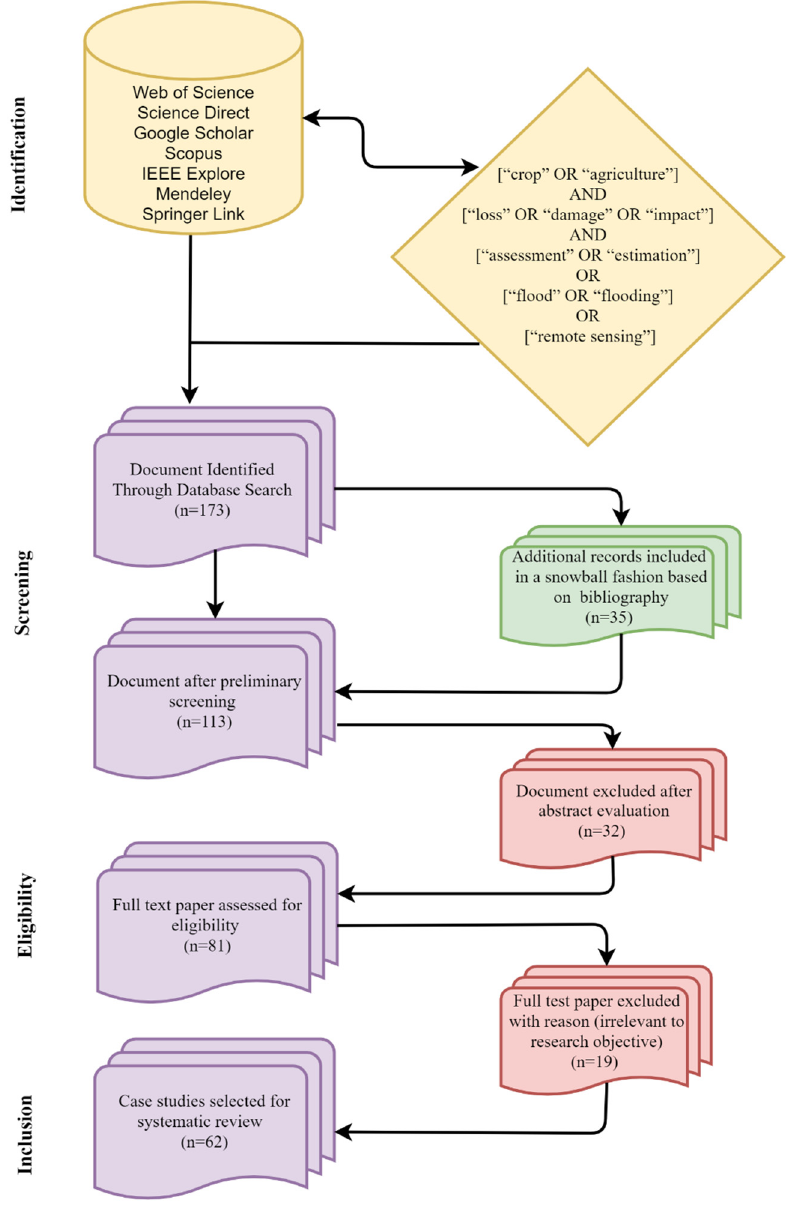
Figure 2. Flow chart for document search, screening, and categorization.